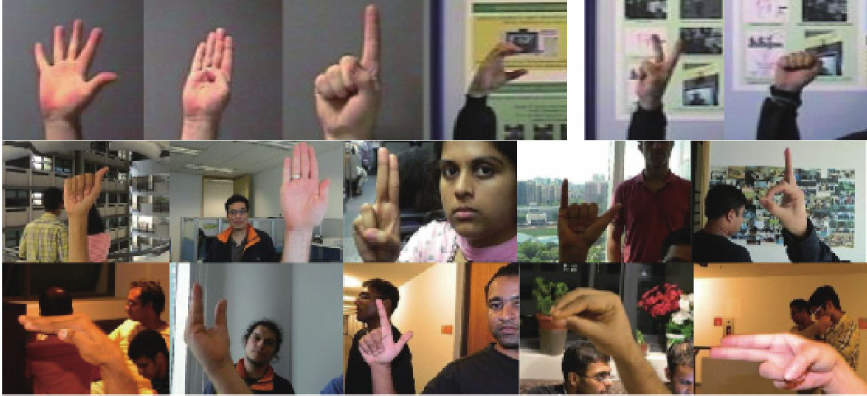
Figure 6. Samples from the NUS-II